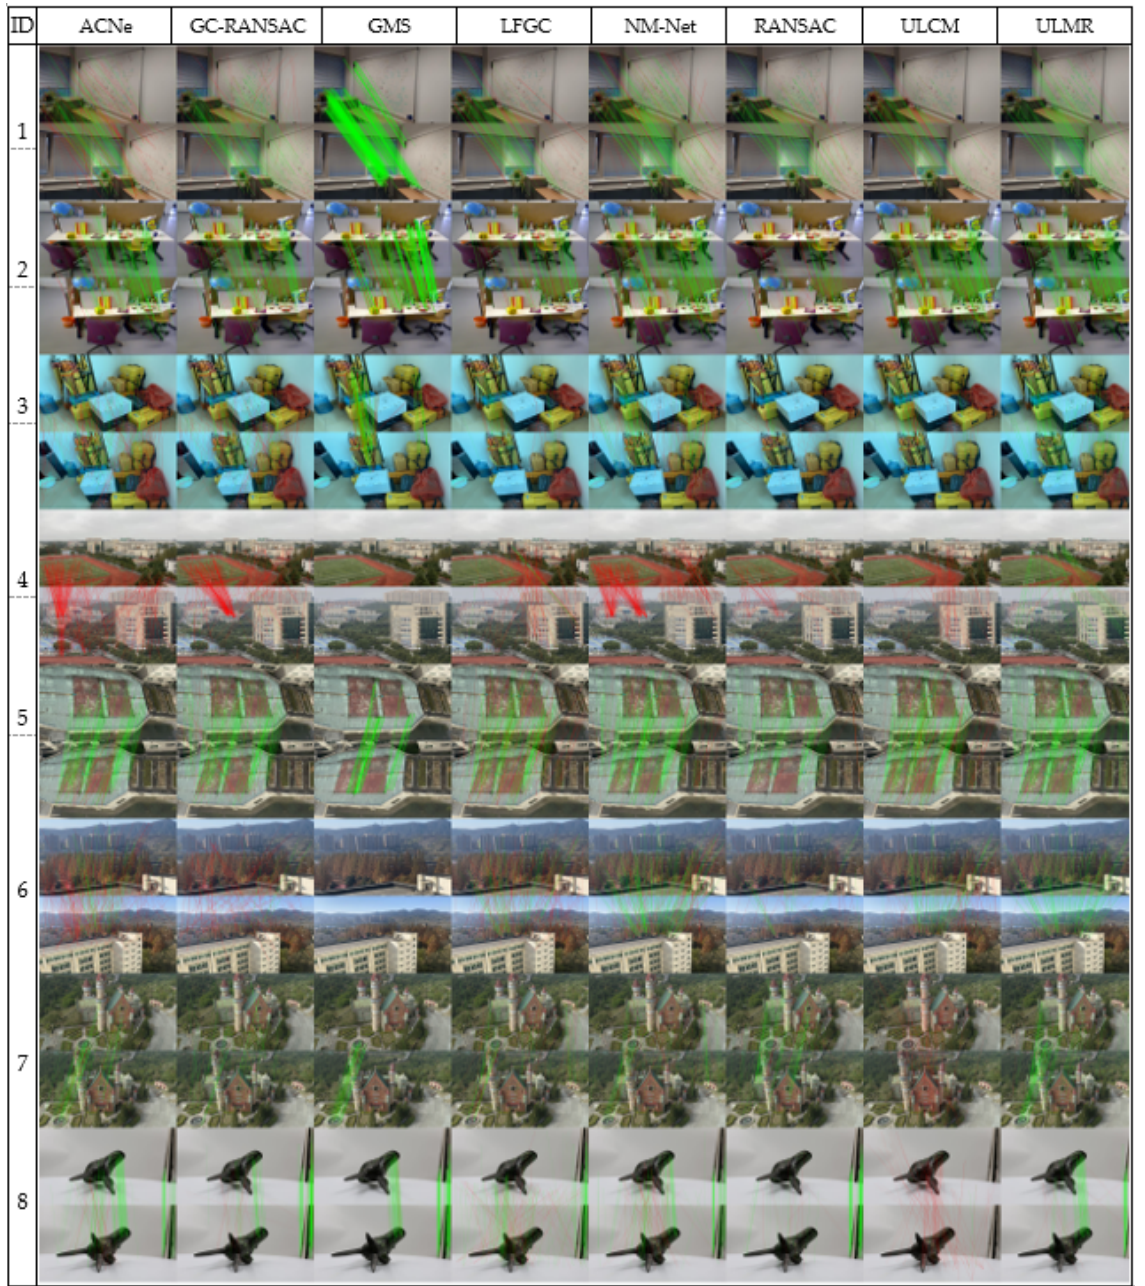
Figure 5. The mismatch removal results of real scenario images. By manually checking, RCM and RFM are connected by green and red lines, respectively.